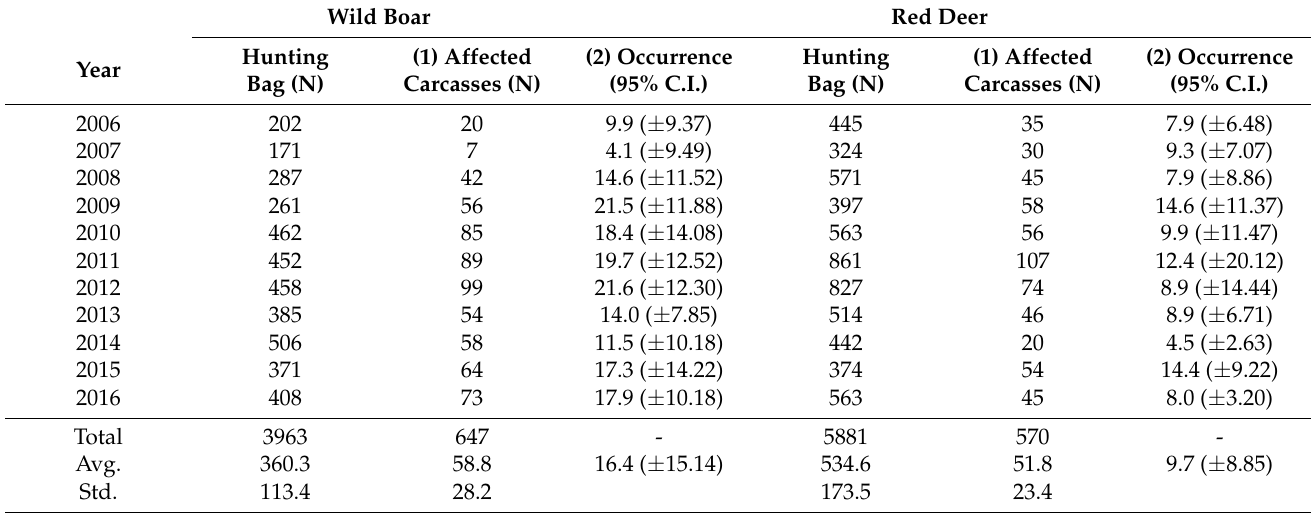
Table 1. Hunting bags of wild boar and red deer and TB occurrence, for the period 2006–2016. Wild Boar Red